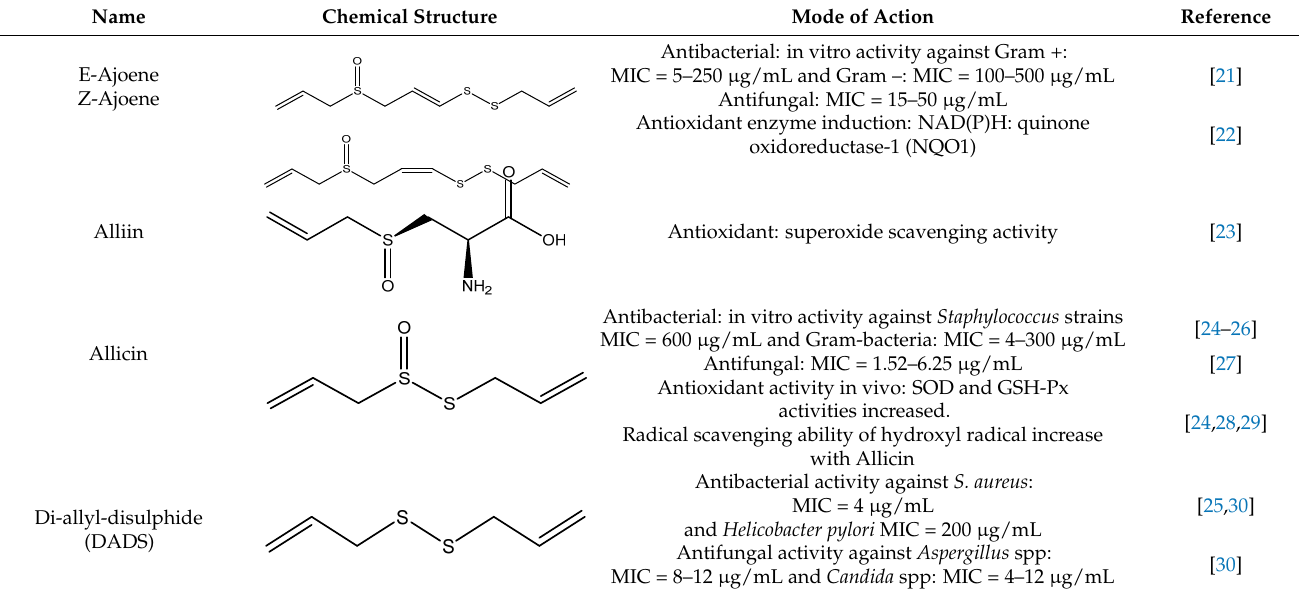
Table 1. Organosulfur compounds present in Allium species, chemical structure and main properties.